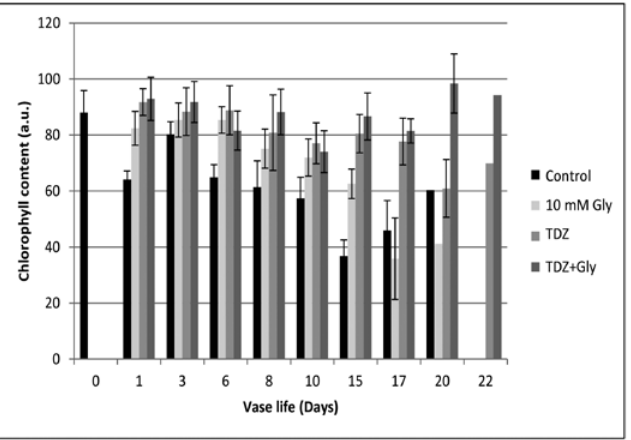
Fig. 1 - Chlorophyll content measured from cut Danae branches dur- ing vase life with a chlorophyll meter and expressed as relative units. Values are means with standard errors ( n=8 ).